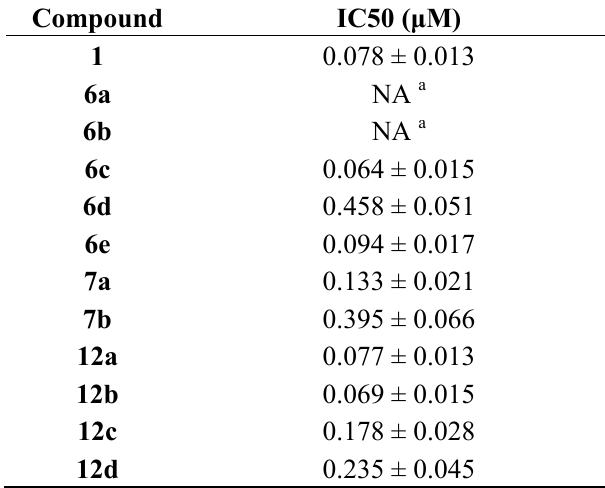
Table 1. Chemotaxis inhibition activity of trisubstituted pyrimidine